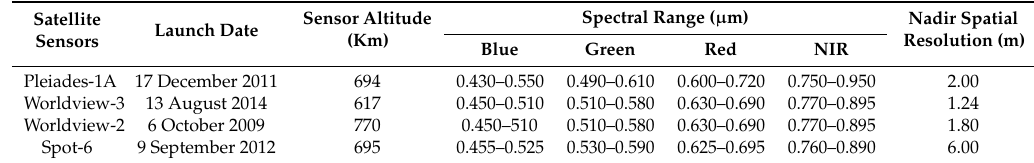
Table 3. Characteristics of satellite sensors used in this